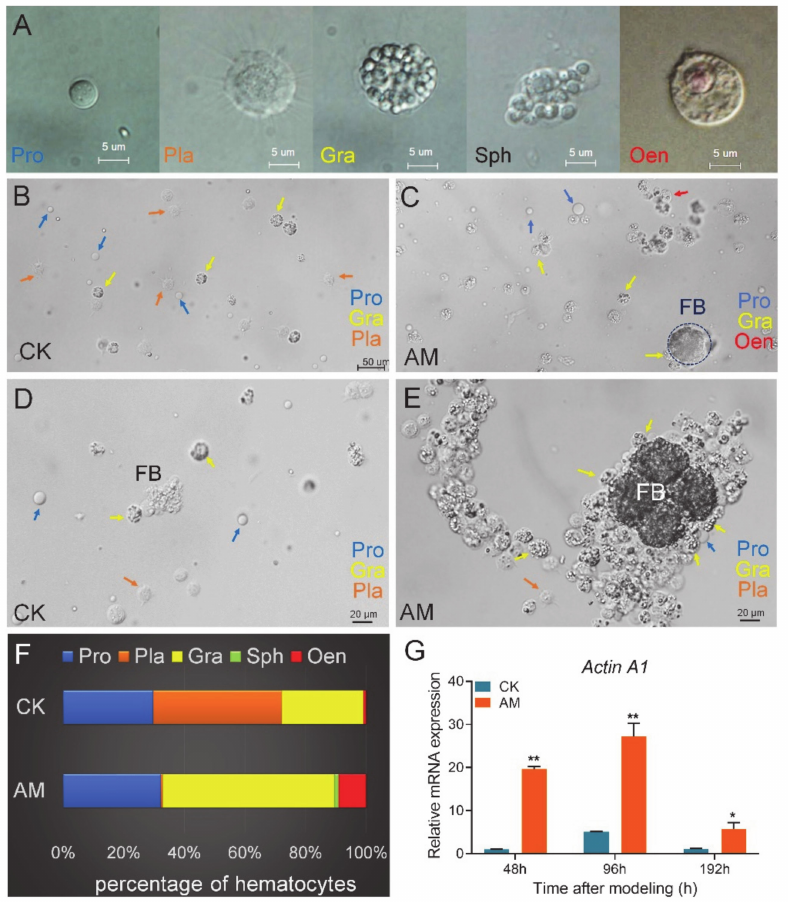
Figure 1. Effect of high plasma protein concentration (PPC) on hemocytes in hemolymph of silkworm. ( A ) Types of hemocytes in hemolymph of the silkworm pupae. Pro, prohemocyte. Pla, plasmacyte. Gra, granulocyte. Sph, spherulocyte. Oen, oenocytoid. ( B , C ) The state and classification of hemocytes status in CK group ( B ) and AM group ( C ) at 48 h after modeling. ( D , E ) A large number of granulocytes gather around the free fat body in AM group ( E ) compared to the CK group ( D ) at 48 h after modeling. ( F ) The proportion of hemocytes at 48 h after modeling. ( G ) The relative mRNA levels of phagocytosis- related marker gene Actin A1 in hemocytes from silkworm at 48–192 h after modeling. * p < 0.05; ** p < 0.01. Mean ± SEM. n =